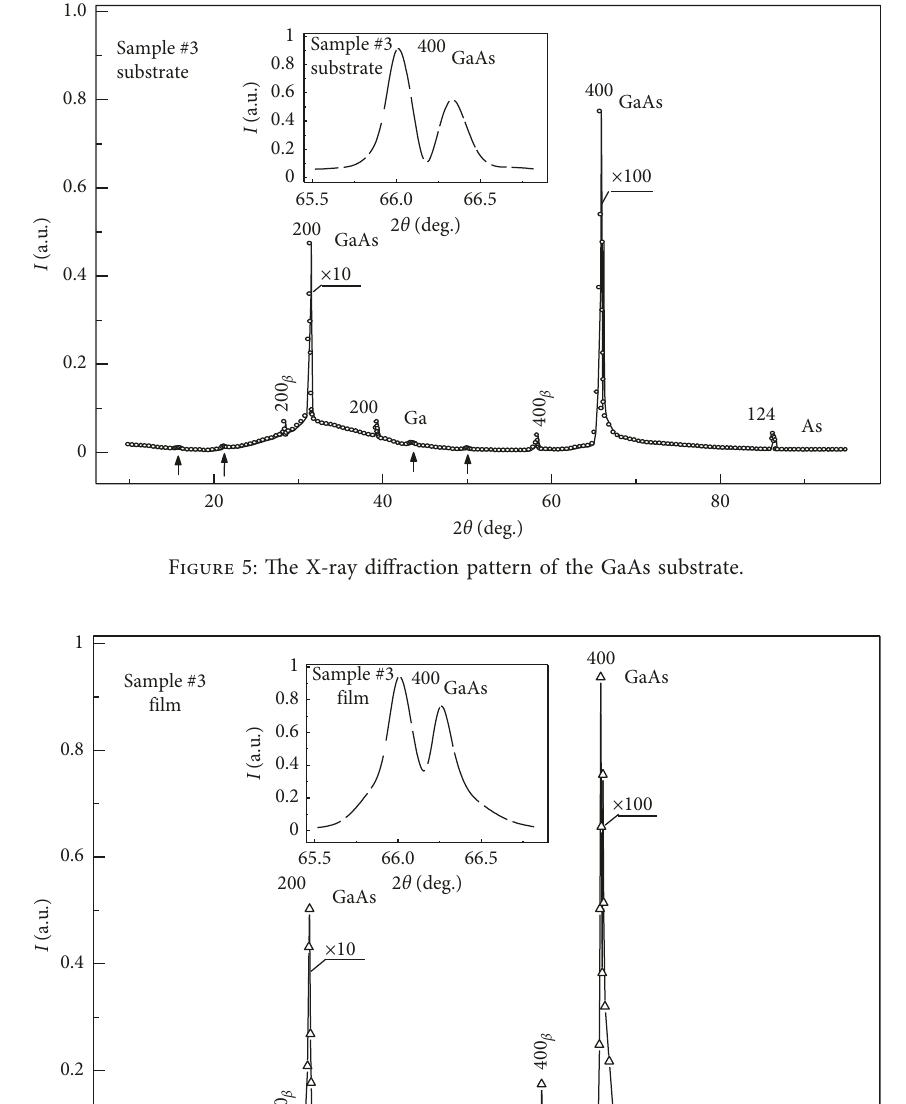
1 − x (ZnSe) x (0 ≤ x ≤ 0.80).